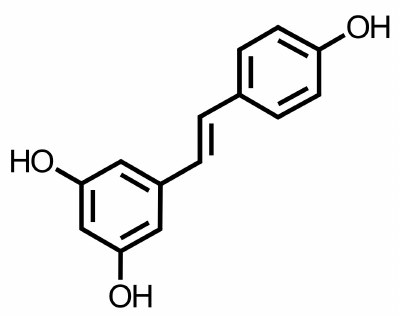
Figure 1. Chemical structure of